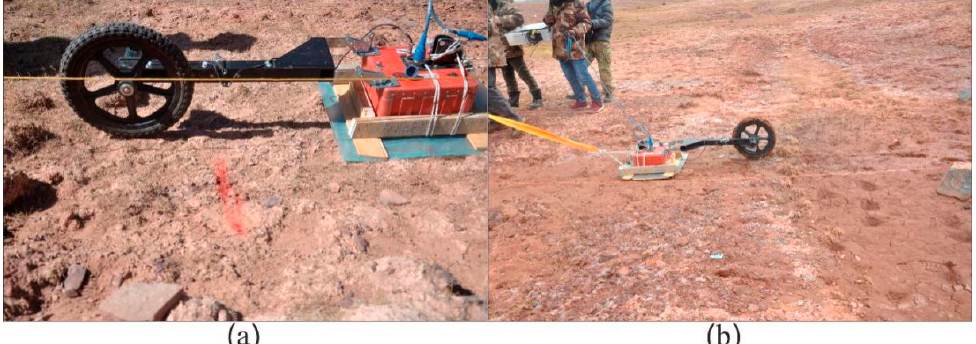
Figure 5. The picture of landscape: ( a ) near picture, ( b ) far picture .